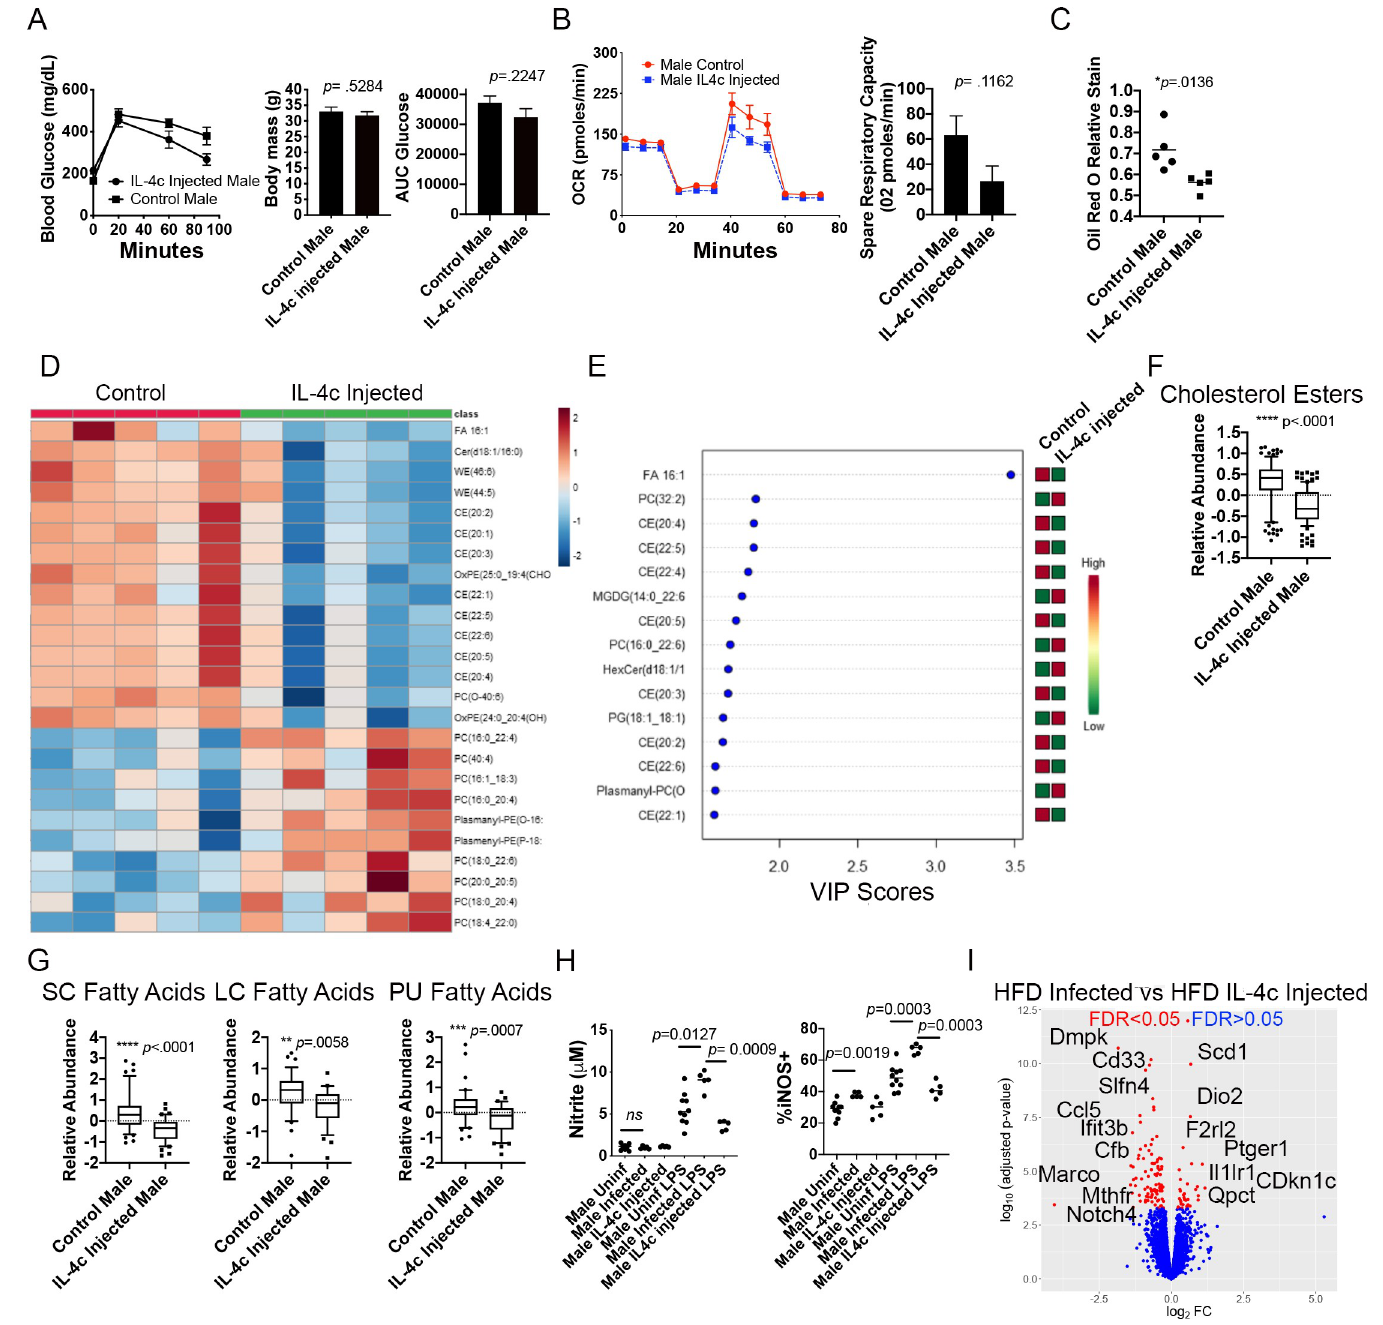
Fig 4. Systemic IL-4 complexes do not protect from HFD-induced weight gain or phenocopy S . mansoni induced BMDM re-programing. ApoE -/- mice on HFD were injected with IL-4 complexes or PBS control for 4–6 weeks. (A) Glucose tolerance test and body weight measurements were performed in ApoE -/- mice at 6–8 weeks post HFD. (B and C) Oxygen consumption rate and spare respiratory capacity were measured at steady state in BMDM from IL-4c injected and control mice. (D) Heat map of 25 top species differentially regulated by systemic IL-4 administration (E) VIP scores from the PLS-DA analysis between control PBS injected and IL-4c treated mice (F,G) Box whiskers plots (10–90 percentile) of relative abundance of cholesterol esters and the indicated free fatty acid classes (data are normalized to sum and treated with pareto scaling, each dot is a single species). (H) Culture supernatants from BMDM stimulated with LPS for 24 hours were assayed for nitrate and iNos (I) Volcano plot of significantly differentially expressed genes between BMDM from S . mansoni infected and IL-4c treated ApoE -/- mice. Graphs are representative of 2 biologically independent experiments with 5–8 mice per group.